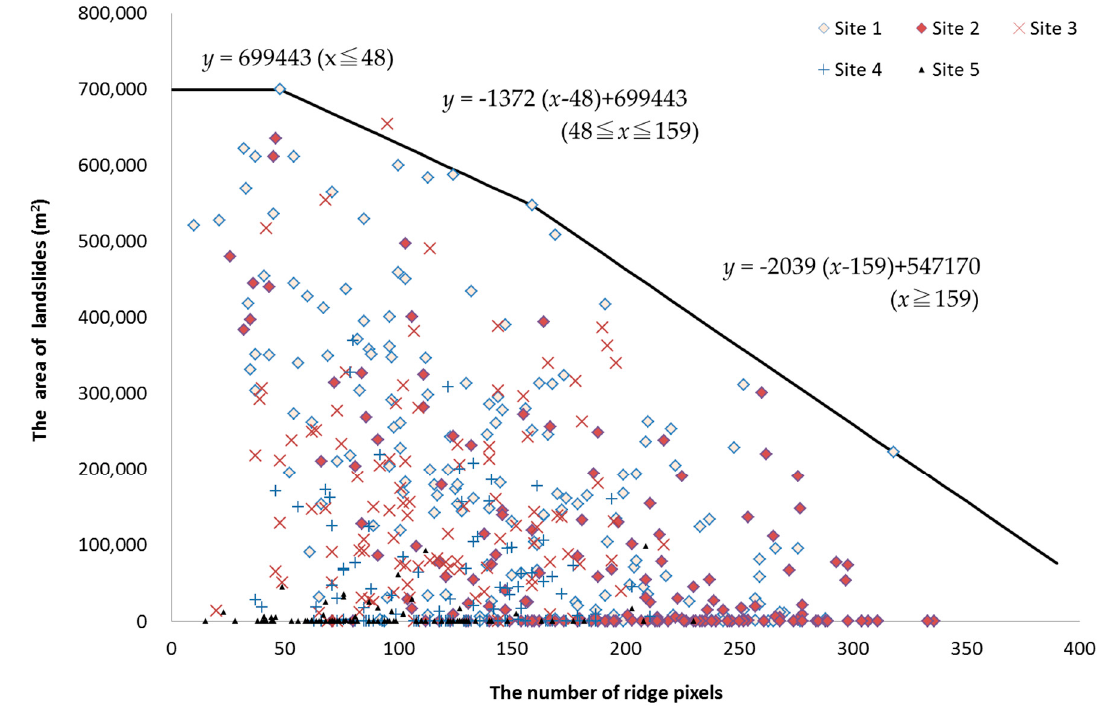
Figure 6. Relationship between the area of landslides and the number of ridge pixels in each 900 m × 900 m grid at Sites 1–5 with upper bound equation derived from data of Site 1.